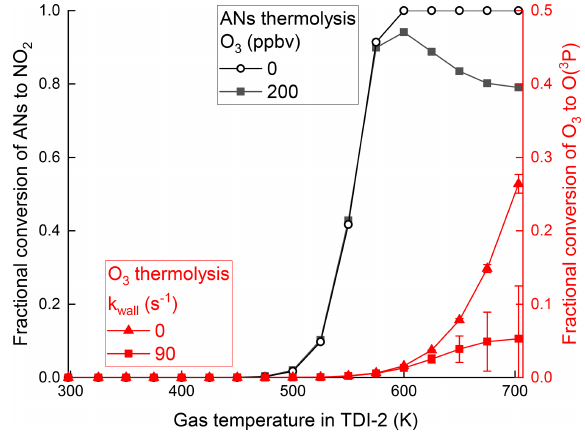
Figure 7. Black lines and data points denote simulated, fractional conversion of n -propyl nitrate to NO 2 for TDI-2 without and with O 3 (200ppbv). Red lines and data points denote simulated frac- tional conversion of O 3 to O( 3 P) within the heated section of TDI-2 with and without wall loss of O( 3 P). Error bars denote the stan- dard deviation (1 σ ) of the fractional conversion changing over time passed in the heated